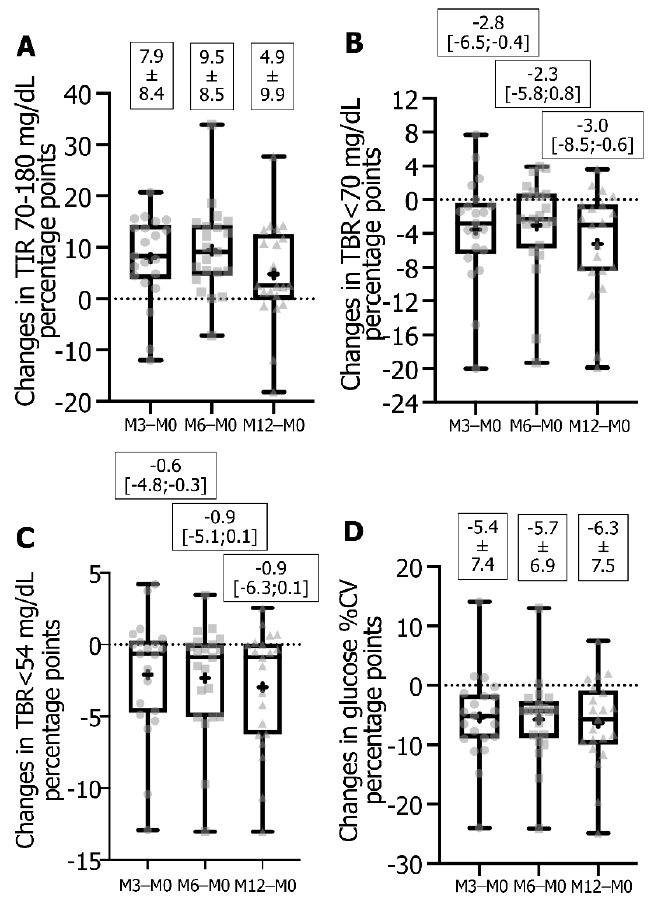
Figure 2. Box-and-whisker plot of changes in TIR ( A ), TBR < 70 mg/dL ( B ), TBR < 54 mg/dL ( C ) and glucose %CV ( D ). Data represented as plots are median, first quartile (Q1 or 25th percentile) and third quartile (Q3 or 75th percentile), min and max, mean (as a cross) and all individual points for changes calculated from DG4 parameter at M3 or M6 or M12 − FSL1 parameters expressed as percentage points. Values indicated are means ± SD or median [Q1;Q3]. Data are from 21 T1D followed-up patients. Abbreviations: %CV, glucose % coefficient of variability; DG4, Dexcom platinum G4; FSL1, FreeStyle Libre version 1; TBR, time-below-range; TIR, time-in-range.